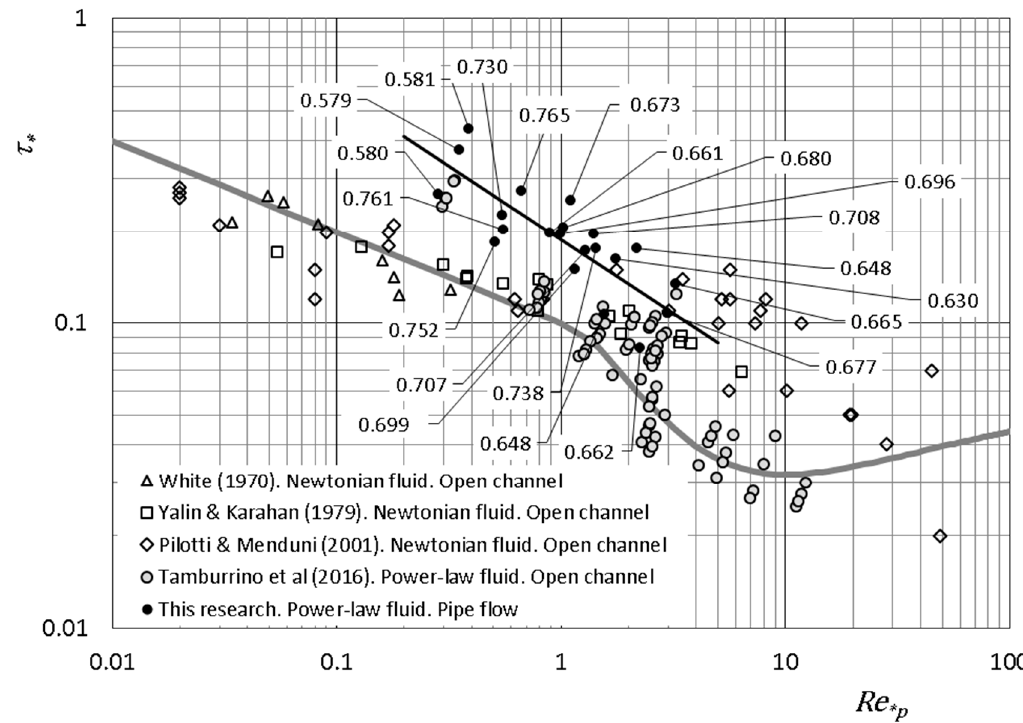
Figure 5. Condition of incipient motion presented in the standard Shields diagram with data corresponding to laminar flows of Newtonian and power-law fluids. The grey line is the Rouse–Mantz fitting to the movement threshold condition. The experimental points corresponding to the incipient condition in a pipe flow (this research, black filled circles) show the value of the flow index. The black line is the threshold condition obtained from Equation (14).